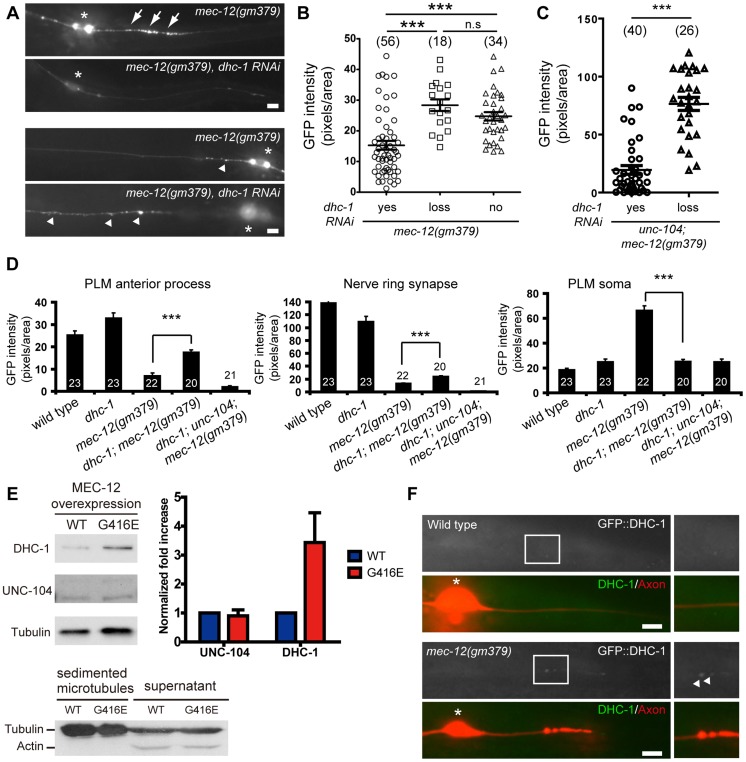
SV mistargeting in the mec-12(gm379) mutant depends on dynein activity.(A) SV distribution in the PLM posterior process (upper panels) and the anterior PLM process (lower panels) visualized by jsIs821(Pmec-7::GFP::RAB-3). Anterior is to the left. Normal and mistargeted SVs were labeled by arrowheads and arrows, respectively. Asterisks, PLM soma. (B-C) Quantification of SV mistargeting in the mec-12(gm379); twnEx42[Pmec-7::dhc-1(sense/antisense)] (B) or in the unc-104; mec-12(gm379); twnEx42 (C) animals. yes, animals with the array expressed in the PLM; loss, transgenic animals with the array lost from the PLM; no, non-transgenic animals. (D) Quantification (mean ± S.E.M.) of SV density upon loss of DHC-1 functions in the mec-12(gm379) mutant. (E) Microtubule sedimentation assay. Microtubules were sedimented from animals overexpressing wild-type MEC-12 or MEC-12(G416E), and probed with antibodies against UNC-104 or DHC-1. Immunoreactivity for 6-11B-1 confirmed the presence of MEC-12 in the samples. Actin was present in the supernatant but not in the sediment, suggesting that the sedimentation procedure was highly successful. n = 3 for each experiment. Quantification (mean ± S.E.M.) and normalization of band intensity were described in Materials and Methods. (F) Epifluorescence images showing the recruitment of GFP::DHC-1 (arrowheads) to the PLM posterior process of the mec-12(gm379) but not the wild-type animals. Boxed regions were highlighted on the right. Axons were marked by jsIs973(Pmec-7::mRFP). Asterisks, PLM soma. Scale bars  = 5 µm. ***, p<0.0001, Mann-Whitney U test.